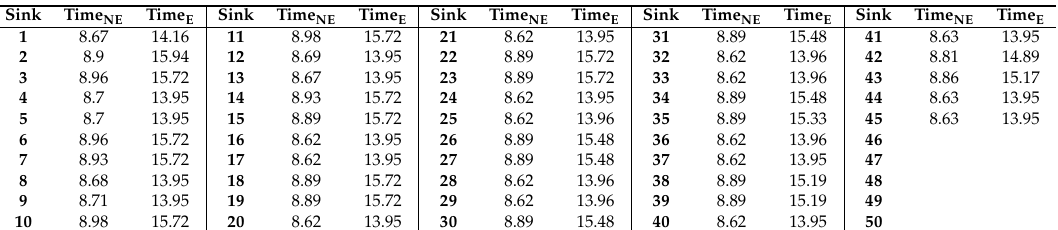
Table 6. Scenario 3: transmission times (in s) for each sink all over the transmission line. (Distance between poles is equal to 100 m, κ = 12, η = 2, NE means no encryption, E means encryption.)